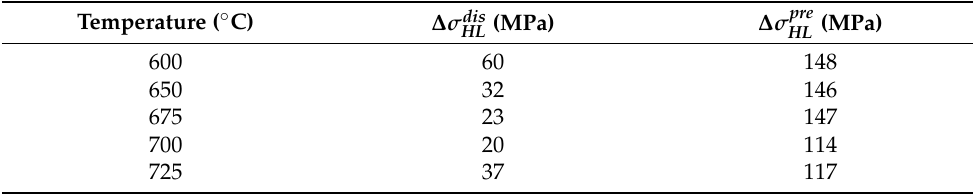
Table 3. Differences in yield strength according to dislocation and